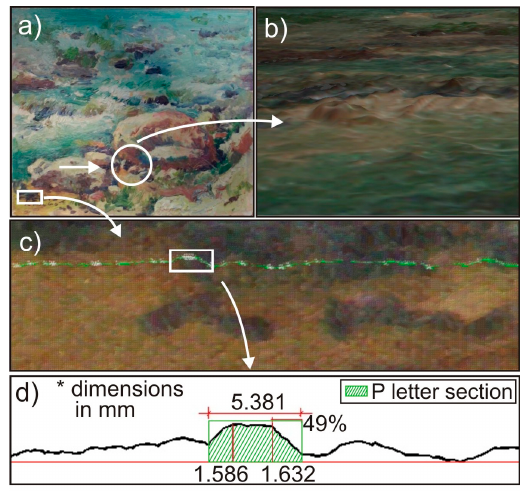
Figure 5. Photogrammetry with DAVID SLS-1 of a real artwork. ( a ) Photo of the wooden panel painting by J. Peris Aragó (0.20 m × 0.25 m); ( b ) Detail of the 3DSDM; ( c ) Part of the signature on the painting, showing detail of the letter “P” (Peris Aragó) and the cross section in green in ( d ) are shown; ( d ) Cross section of part of the signature of the painting marked in ( c ). One can see all the geometrical characteristics of the section of the letter “P” in the signature (width, heights and slope of the right side).